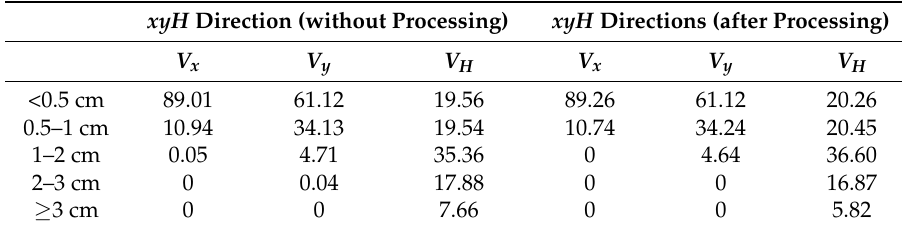
Table 4. Statistics of differences in position in relation to the coordinate time series of the monitoring point (%). xyH Direction (without Processing) xyH Directions (after